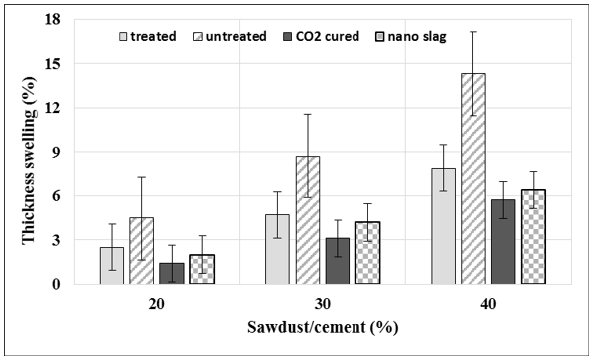
Figure 4: Thickness swelling of cement-bonded particleboard prior to and after different accelerated effects.